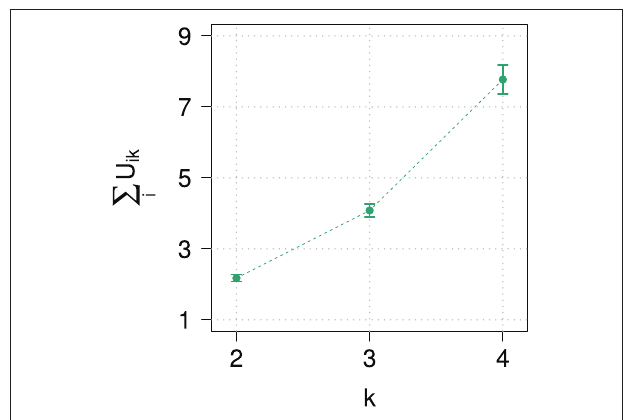
the vicinity of 1. 18 σ 2 α models the variance of α and is drawn from an inverse Gamma distribution.